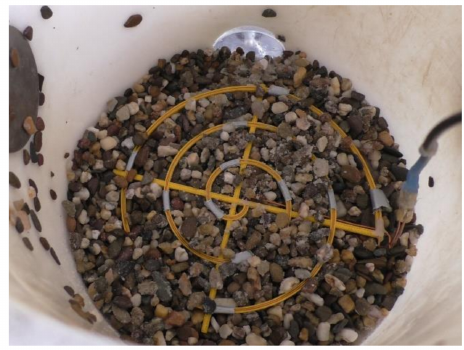
Figure 7. Flat coil sensor embedded in the proctor mould.